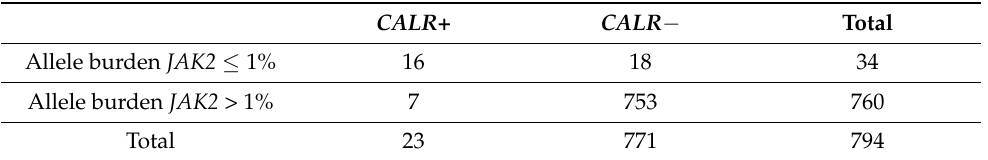
Figure 4. Result of ROC analysis. ( A ) ROC curve of dependence of sensitivity on specificity for an indicator of predicting the presence of a combined mutation according to the level of the JAK2 V617F allele burden. ( B ) Sensitivity and specificity of detecting a combined mutation as a function of the threshold level of the JAK2 V617F allele burden. Table 4. Association of low JAK2 allele burden with CALR mutation. p -value from Fisher’s test was used to estimate